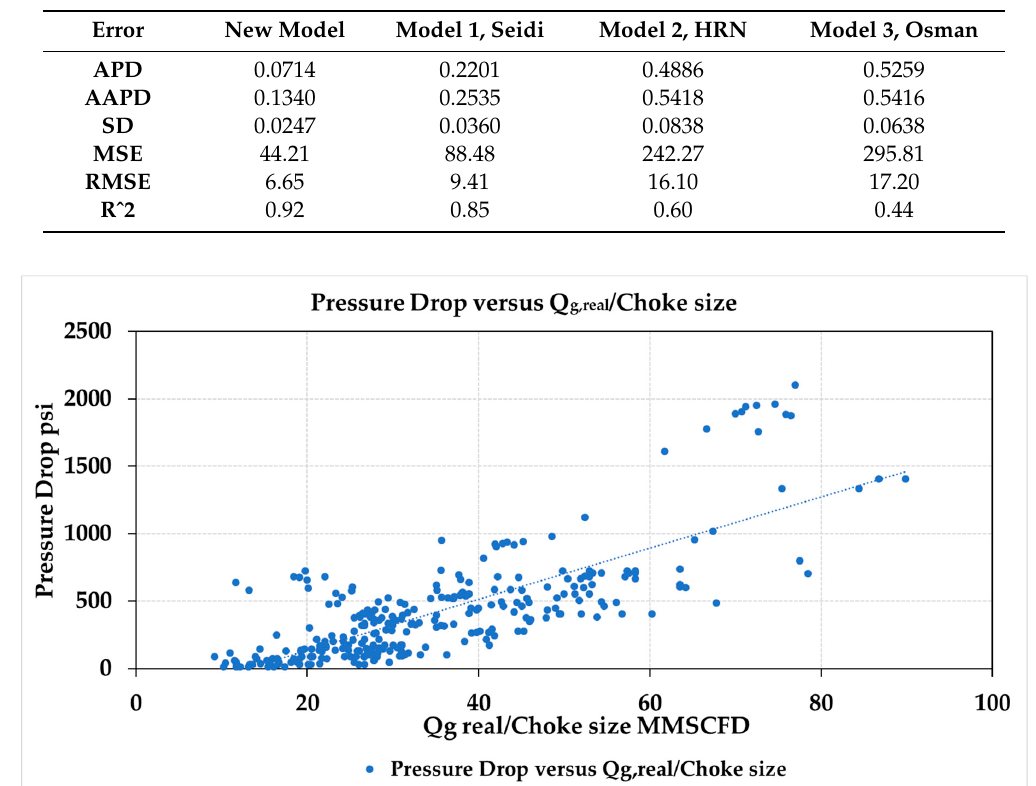
Figure 4 . Pressure drop across the choke vs flow rate per choke size .